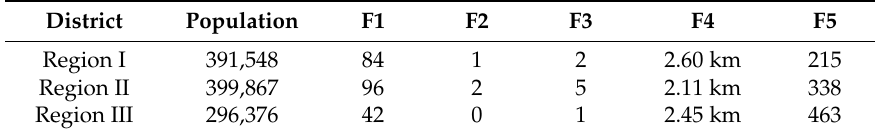
Table 2. Details of districts selected for case